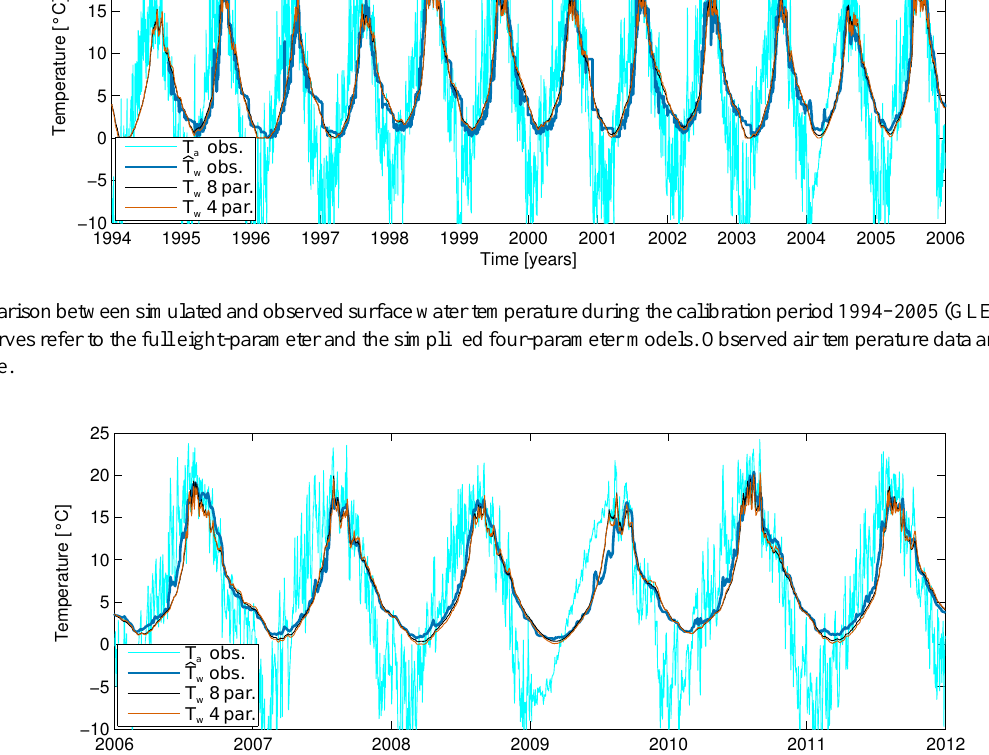
Fig. 10. Comparison between simulated and observed surface water temperature during the validation period 2006–2011 (GLERL simula- tion). Simulated curves refer to the full eight-parameter and the simplified four-parameter models. Observed air temperature data are also presented with cyan line.